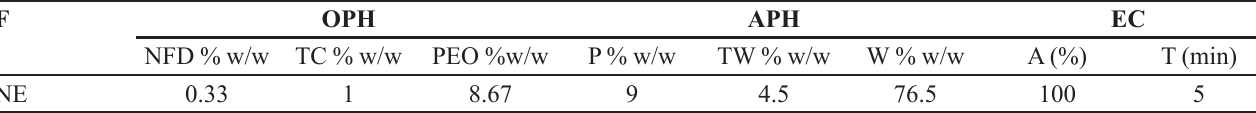
TABLE I - Components and experimental condition